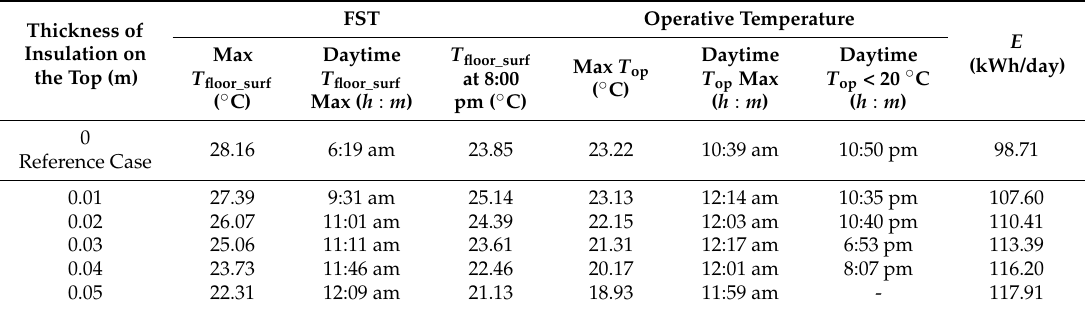
Table 7. Results of the parametric study: Impact of the top layer insulation thickness.